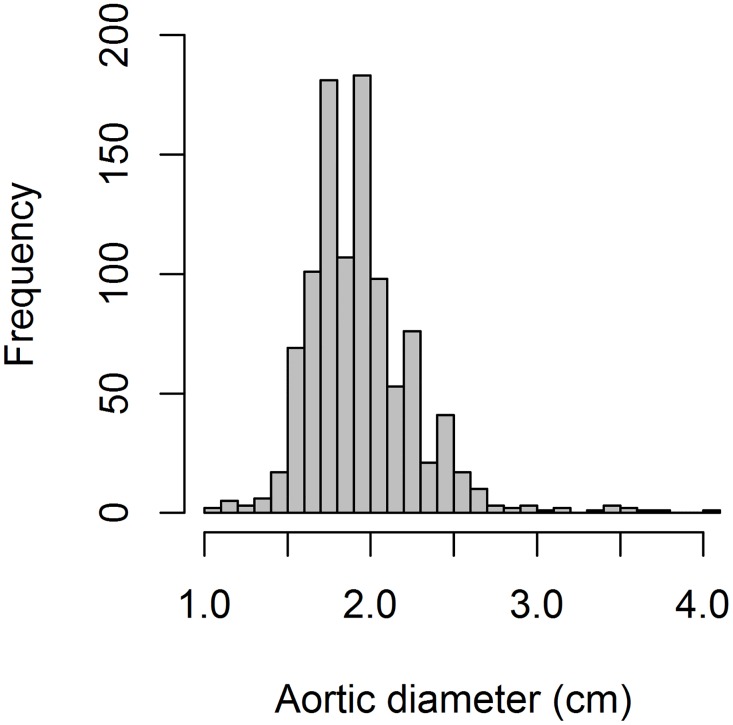
Distribution of aortic diameters.